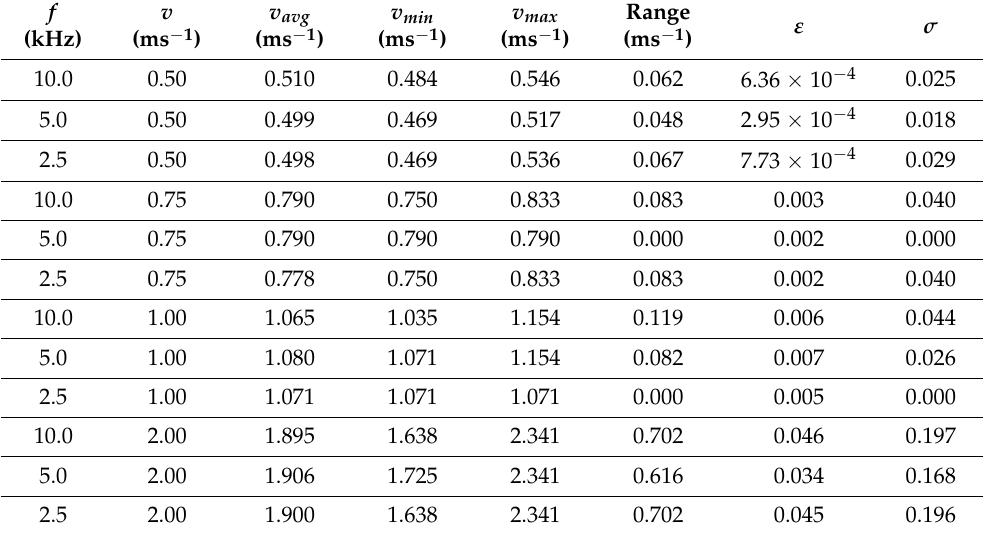
Table 2. Qualitative indicators obtained for four velocity values ( v ) and different sampling frequen- cies ( f ).